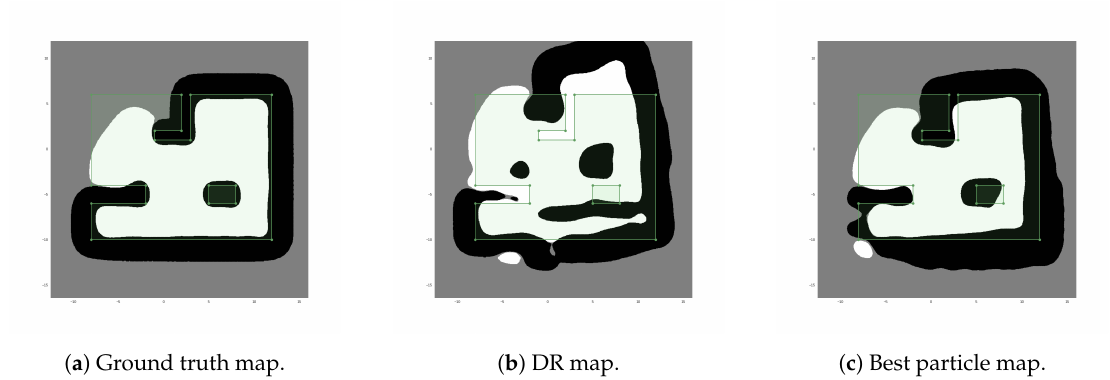
Figure 14. Position error of the filters compared to ground truth (SLAM).